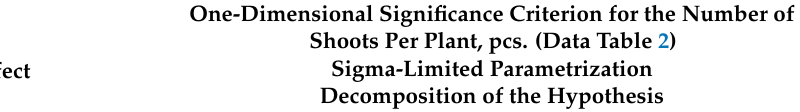
Table A1. Results of multivariate analysis of variance values of H. grandiflorum shoot multiplication coefficient in vitro